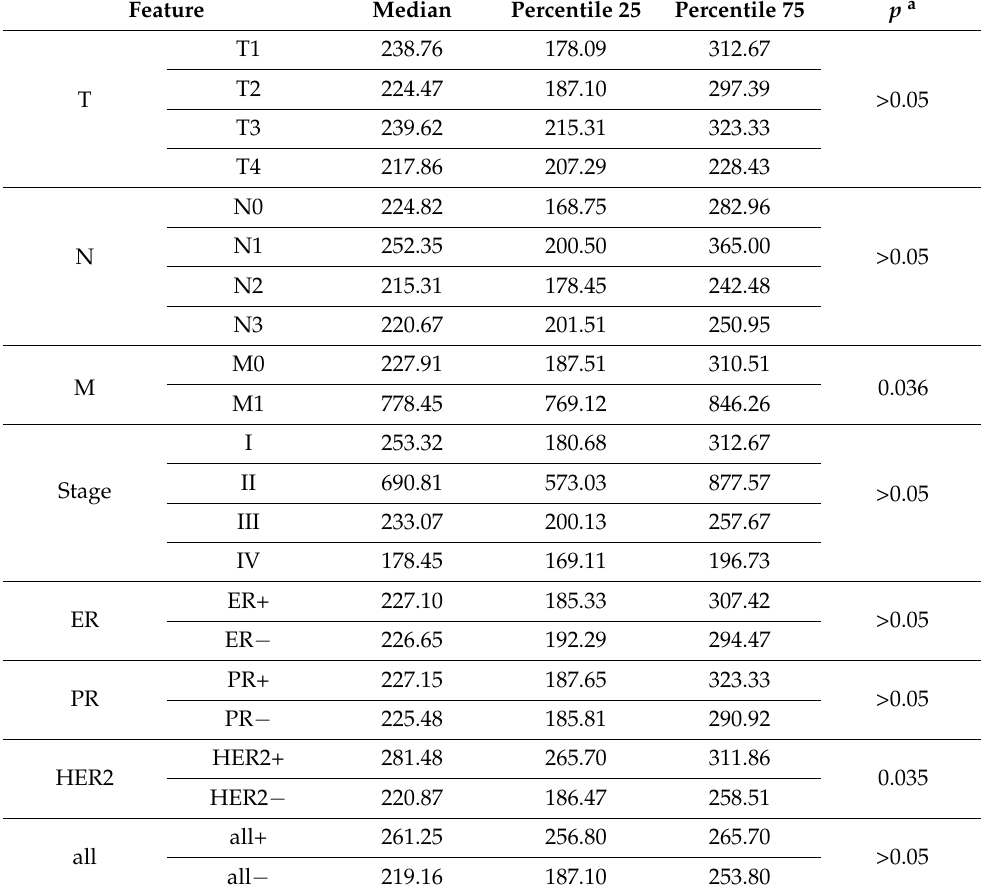
Table 8. Expression of uc.63 in breast cancer patients depending on clinical-pathological